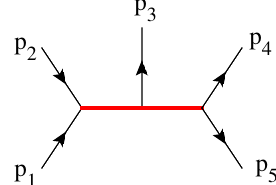
Figure 2 . The (cid:12)ve point diagram built from cubic vertices, with arrows indicating the momen- tum